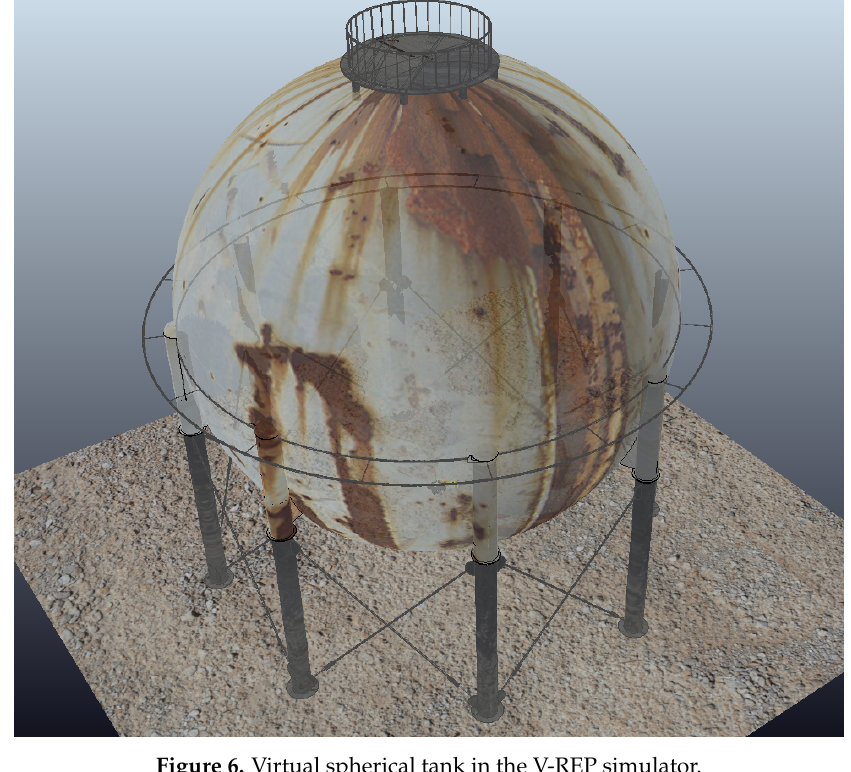
Figure 6. Virtual spherical tank in the V-REP simulator.